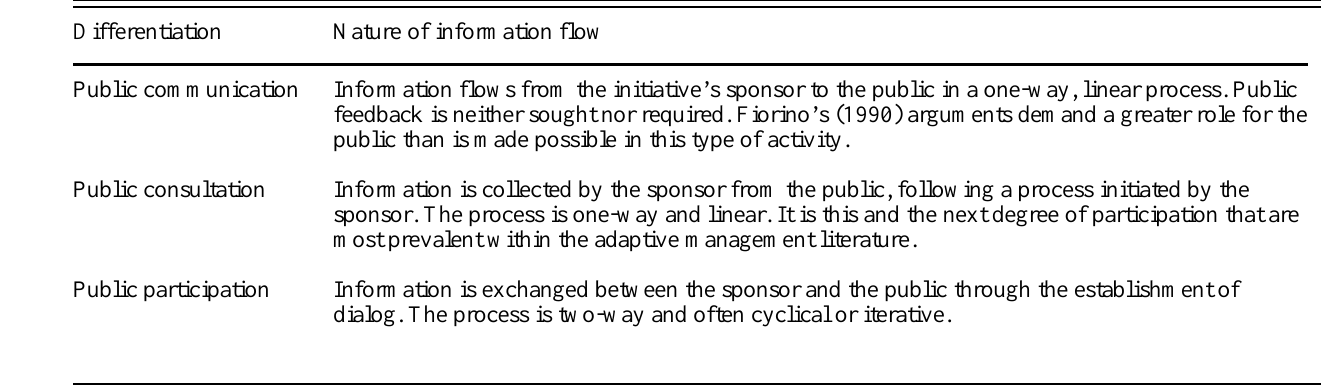
Table 2. Different forms of participatory involvement in environmental management projects (developed from Rowe and Frewer (2005)) Differentiation Nature of information flow Public